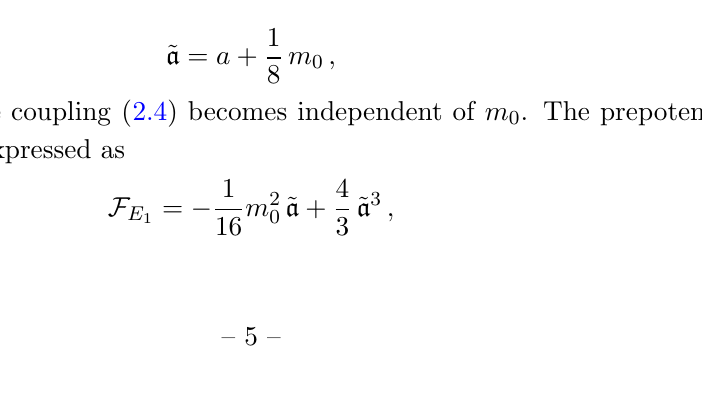
0 gauge theory (or E 1 theory). (b) A 5-brane web for E 1 e